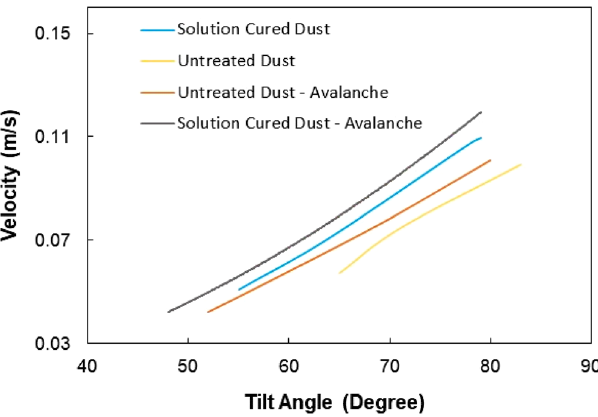
Figure 8. Average dust particle velocity with glass surface tilting angle for solution cured and untreated dusts with and without avalanche